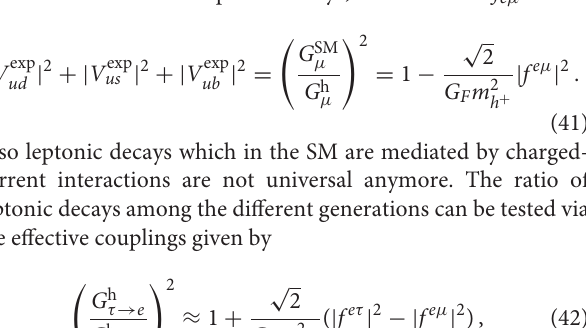
FIGURE 15 | Neutrino mass generation from gauged lepton number